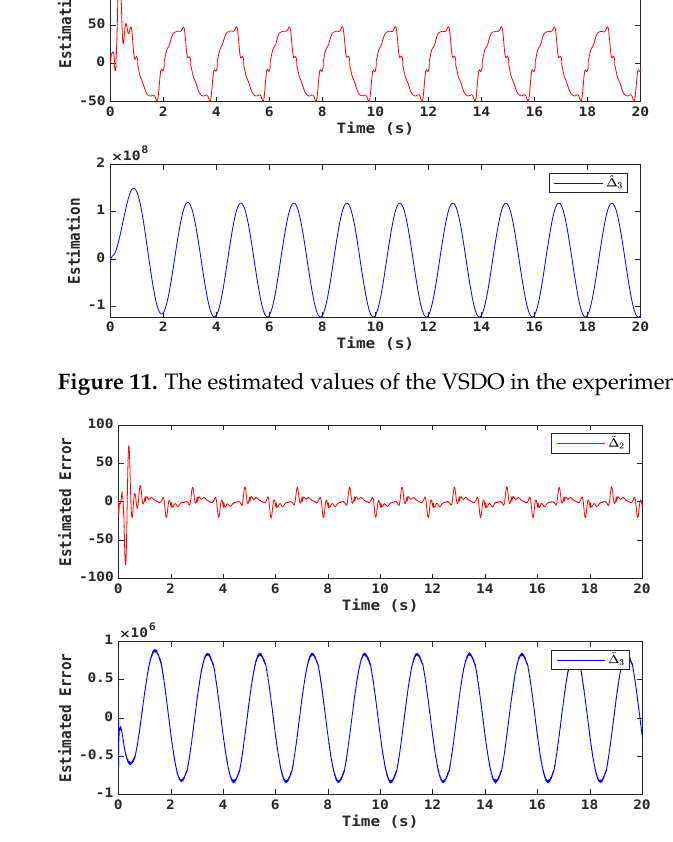
Figure 12. The estimated errors of the VSDO in the experiment.